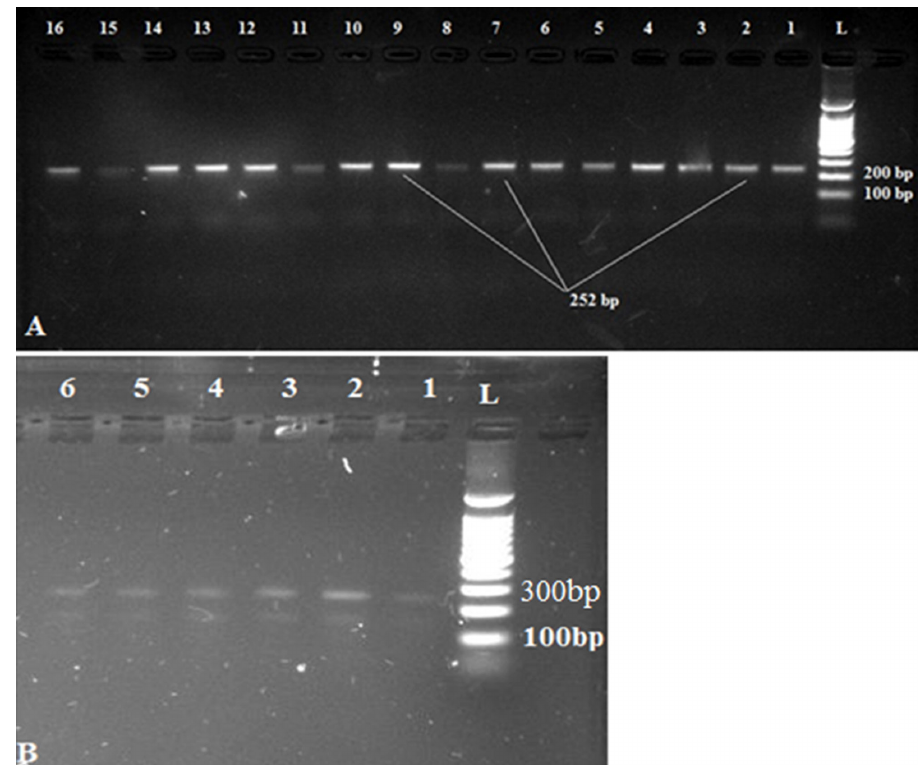
Fig. 1. Genotyping polymorphism of BCL-2 (-938C > A) with PCR product, A; and RFLP-PCR fragments, B. The wild type CC allele of the BCL-2 promoter region produced a single 252-bp fragment, the AC allele produced 252bp and 154bp fragments, and the AA allele produced 154bp and 98bp